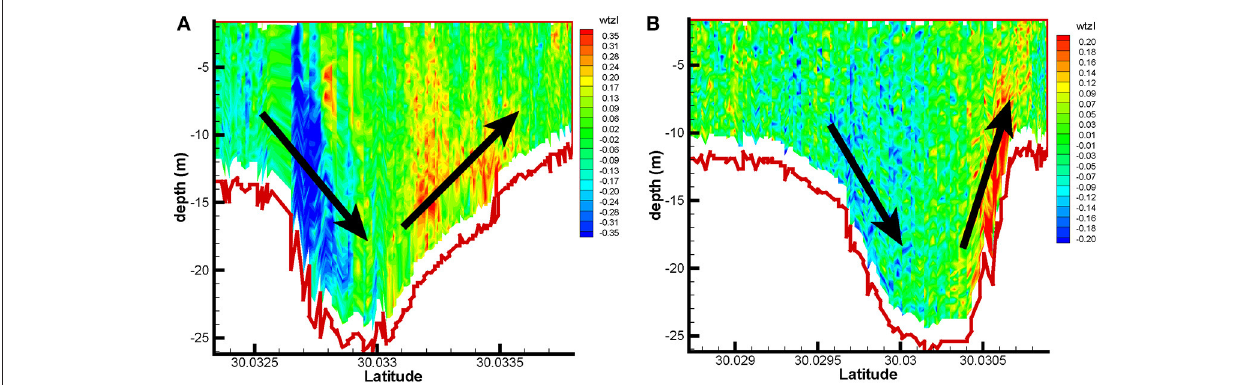
FIGURE 2 | Profiles of vertical velocity over the scour hole A (a) and B (b) for the first two transects (No. 1,2 in Table 1). A and B are shown in Figure 1 .